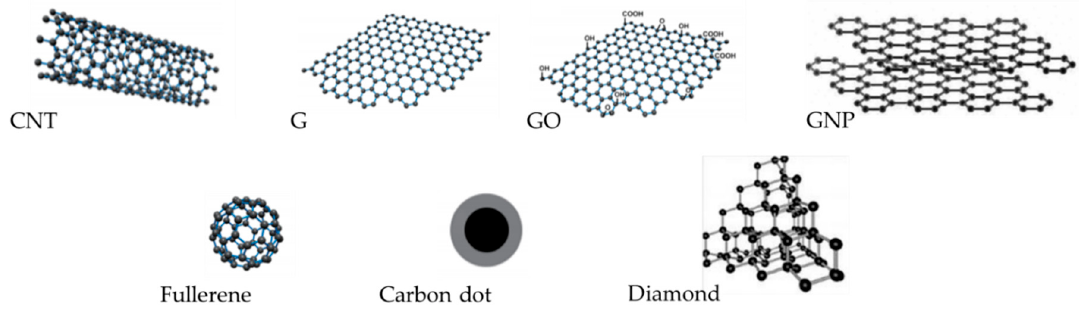
Figure 3. Carbon-based nanomaterials (modified from [117]).